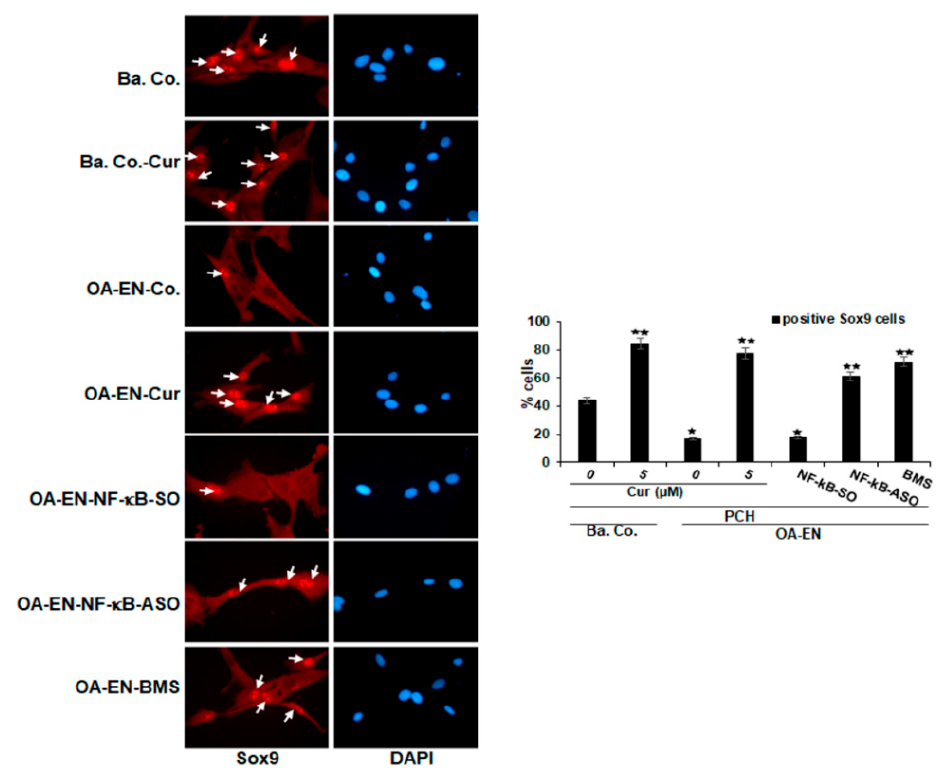
Figure 3. Influence of curcumin, NF-kB-ASO or BMS-345541 upon the Sox9 in OA-EN as visualized by immunofluorescence. Chondrocytes in monolayer cultures by themselves (Ba. Co.) or in co-culture with fibroblasts and T-lymphocytes (OA-EN) were maintained untreated or treated with curcumin for 4 h, or OA-EN cultures were transfected with NF-kB-SO or NF-kB-ASO or treated with BMS-345541 as outlined in Materials and Methods. Figure magnification 600x; scale bar = 30 mm. As a minimum, each experiment was done in triplicate, and positively labeled Sox9 nuclei (white arrows) were quantified based on counting 500–600 cells taken in 25 separate microscopic frames. Scores (cid:70) (cid:70)(cid:70) were matched against control and p < 0.05 ( ), p < 0.01 ( ) were deemed statistically